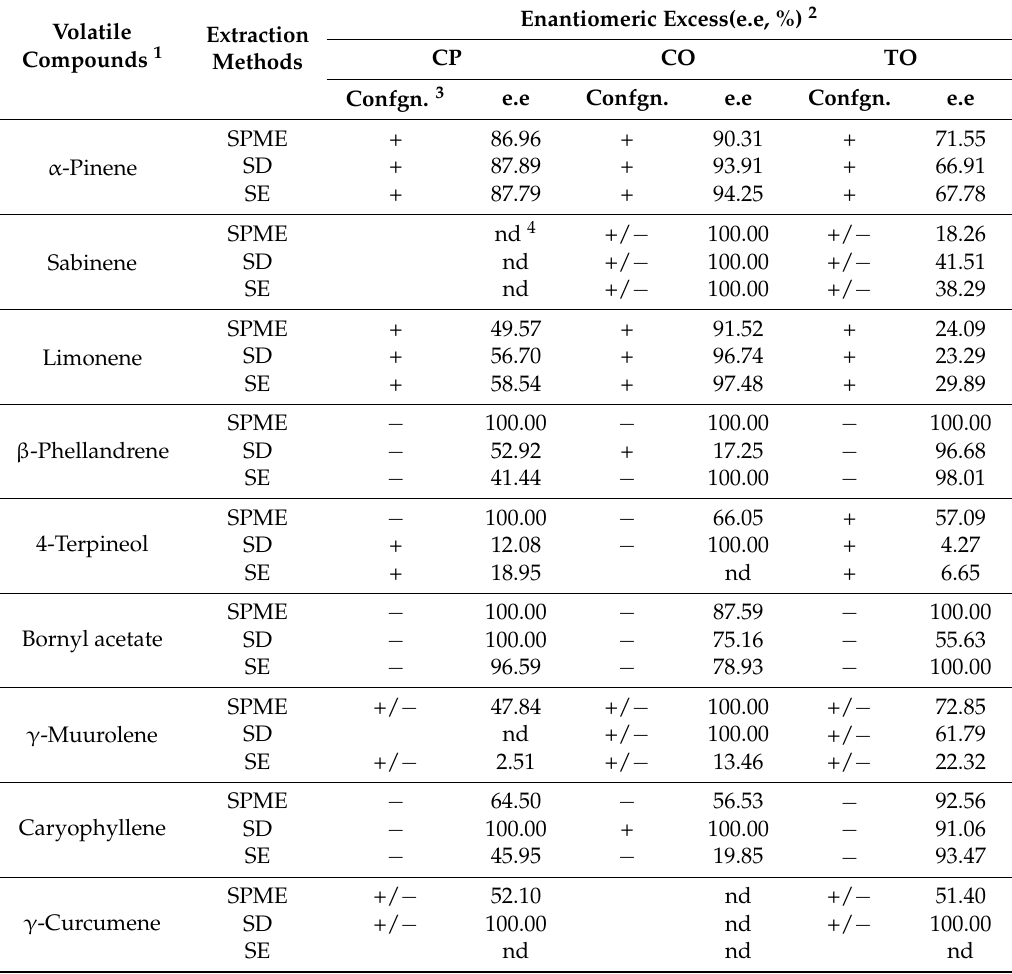
Table 4. Enantiomeric excess (e.e) and configuration of chiral terpenes extracted from three different cultivars based on three different extraction